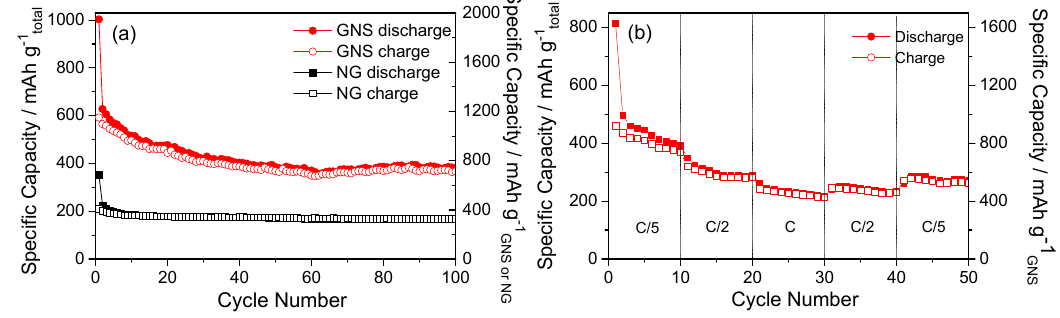
Figure 6. Cycling performance of NG and GNS electrodes at a rate of C/5 ( a ); Rate capability test of the GNS electrode ( b ).